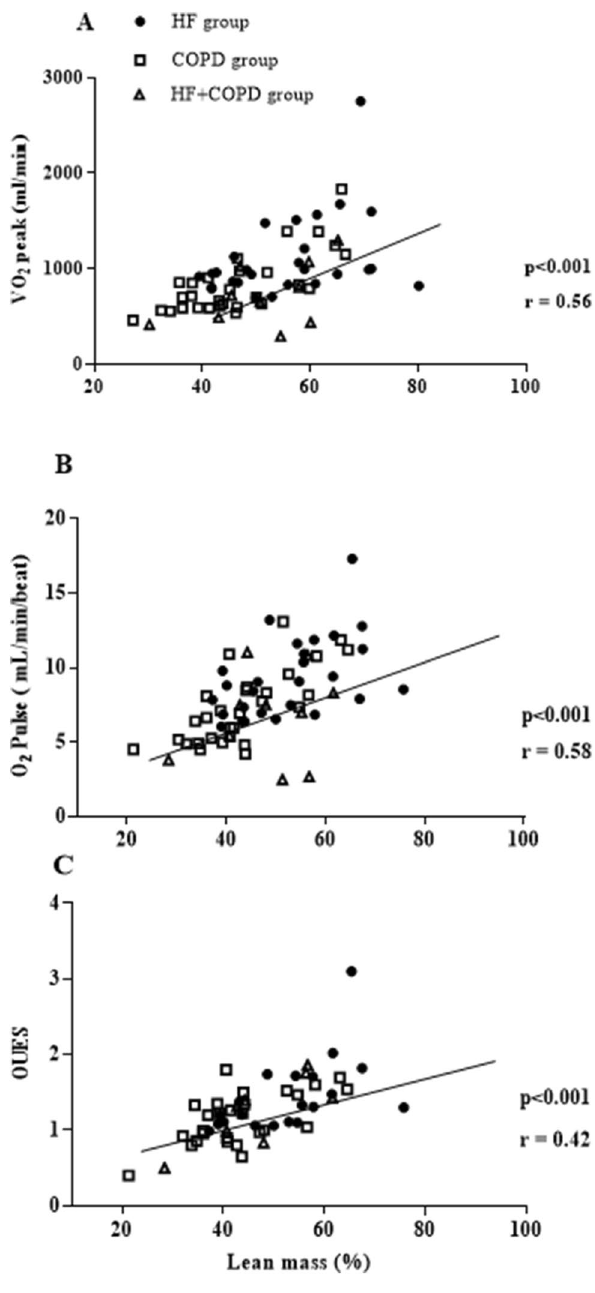
Figure 4. Correlation between body composition and CPET responses; Used Pearson correlation coefficient. ˙ V ( A ) Relationship between lean mass and oxygen uptake ( O 2 ); ( B ) relationship between lean mass and Oxygen pulse; ( C ) relationship between lean mass and oxygen uptake efficiency